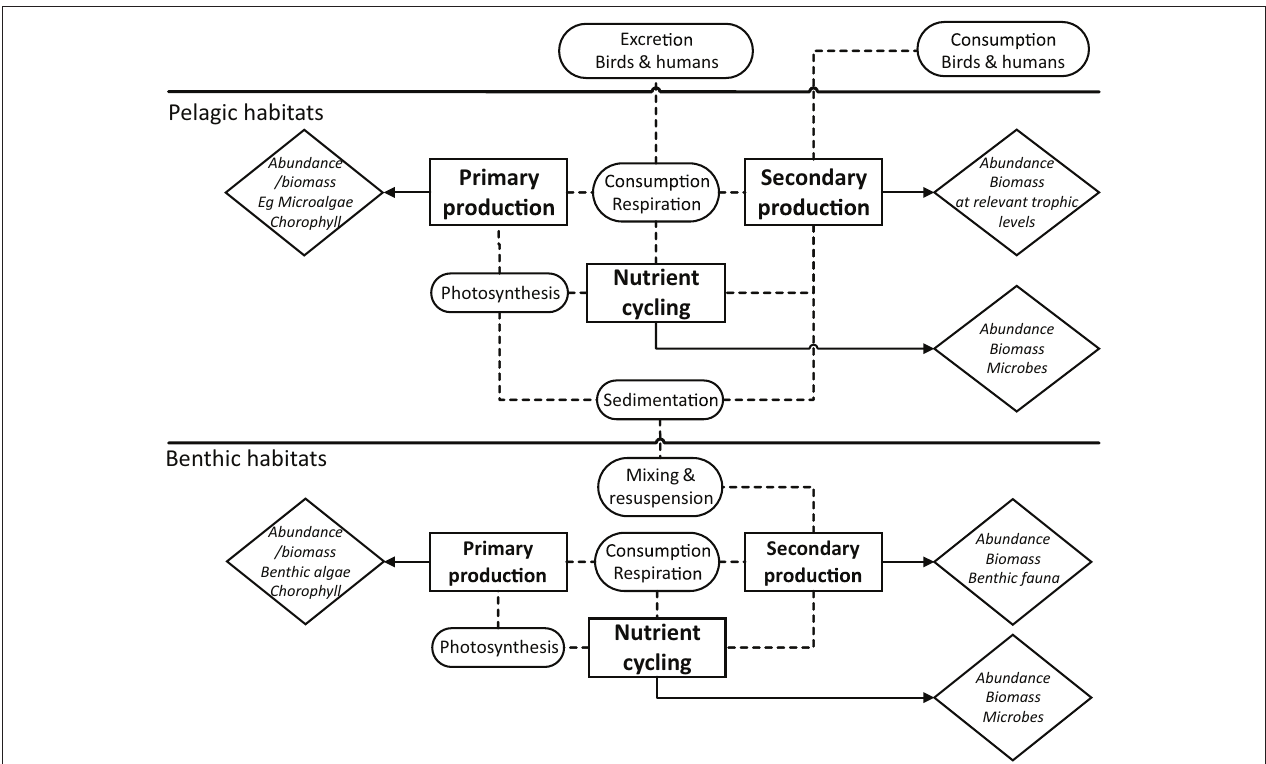
FIGURE 3 | Conceptual illustration of the major functions within marine ecosystems, as a basis for structuring ecosystem-orientated biodiversity assessments. Note that functions such as habitat provision, reproduction, etc., are implicit within the concept.